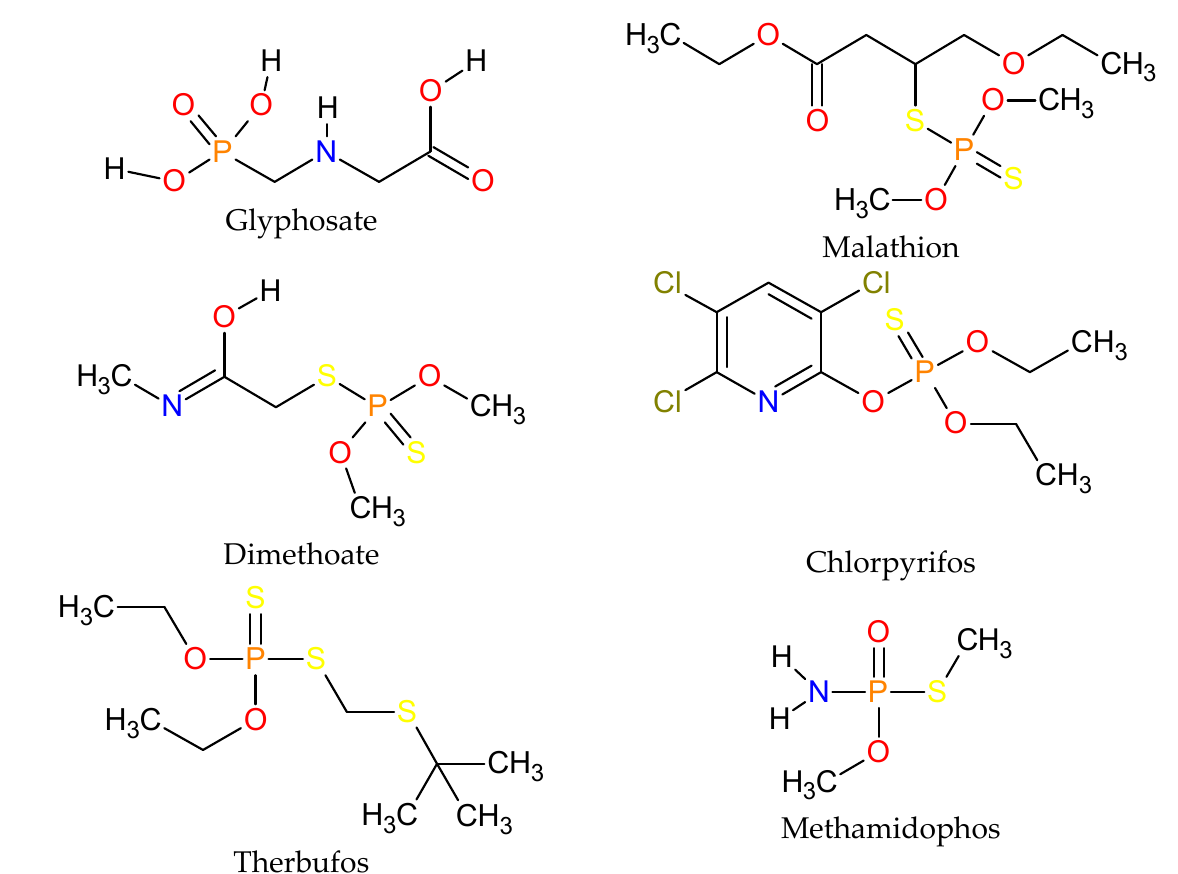
Figure 2. Structural formula of the main organophosphates (OPs).